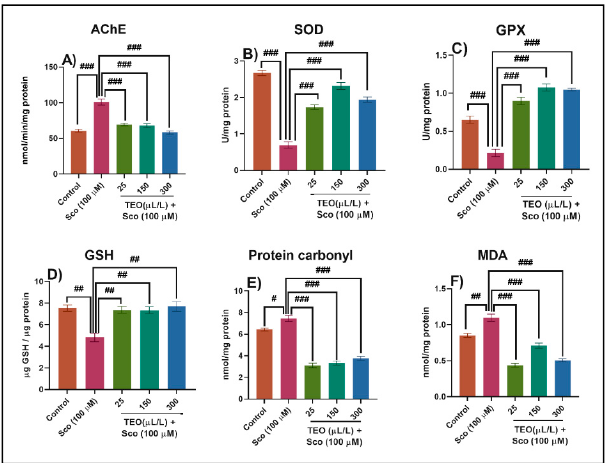
Figure 5. Thymus vulgaris essential oil (TEO: 25, 150, and 300 µL/L) exhibited an anti- acetylcholinesterase (AChE) e ff ect and improved brain antioxidant status. The enzyme’s specific activities: ( A )